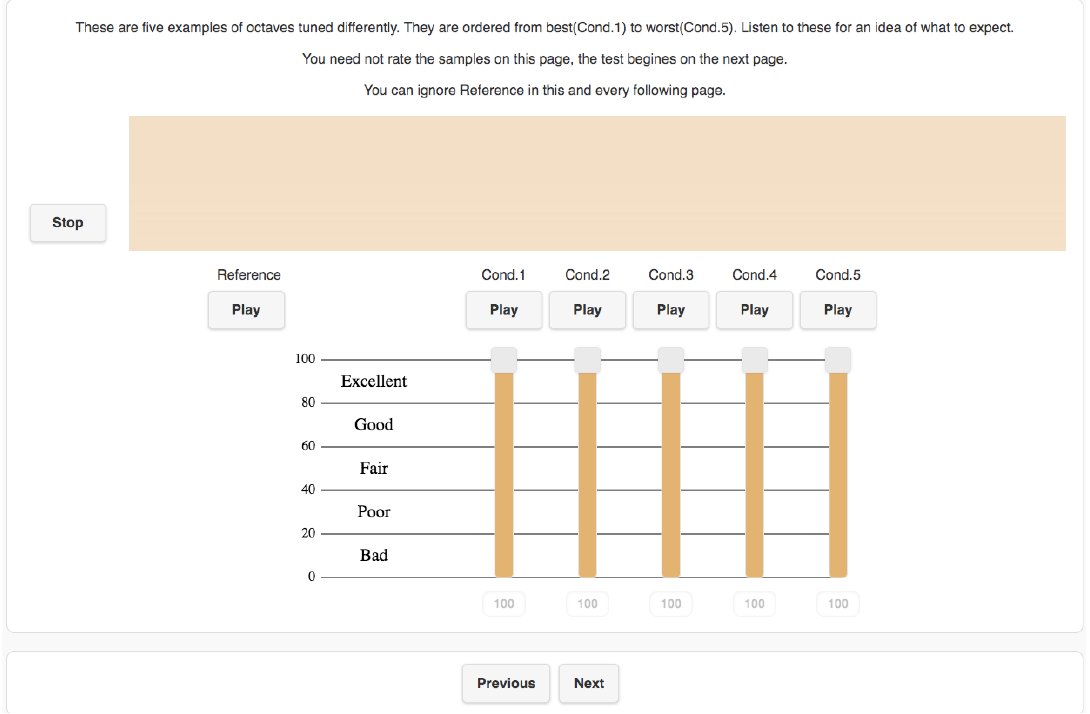
Figure 1. Screenshot of the listening test